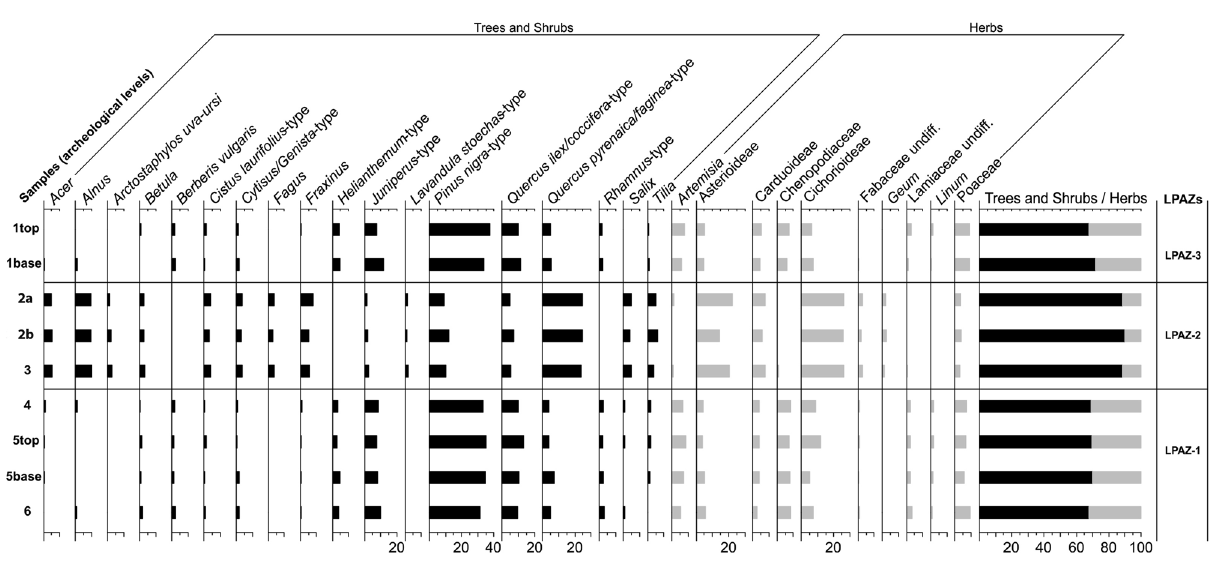
Figure 7. Percentage pollen diagram from the Peña Capón